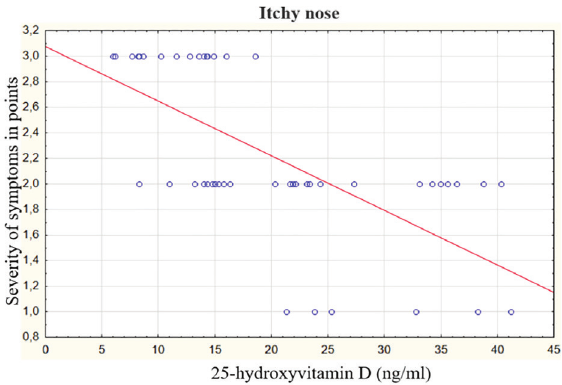
Figure 5d - correlation the itchy nose with vitamin D